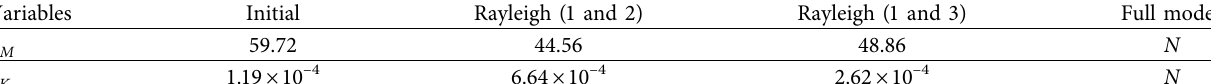
Table 5: Comparison of the parameters of the Rayleigh damping model before and after updating for case 1. Variables